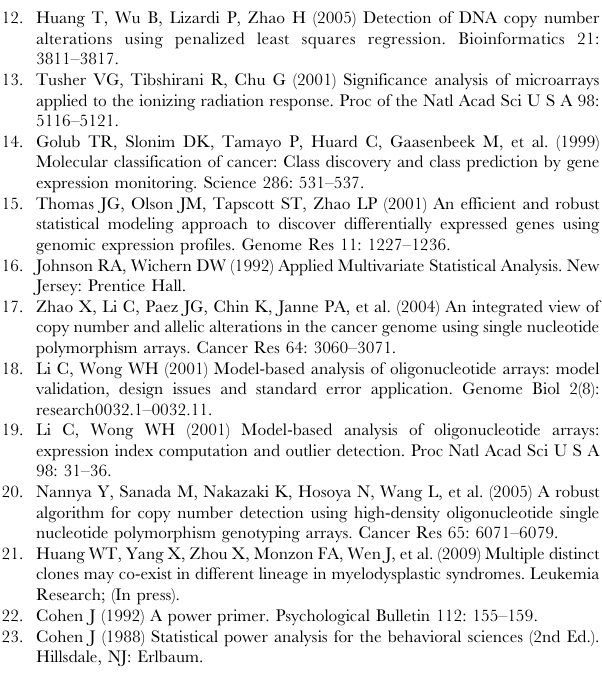
Table S3 Copy number aberrations comparison of CMA algorithm and CNAG (MDS-7 is excluded). The cutoff value of